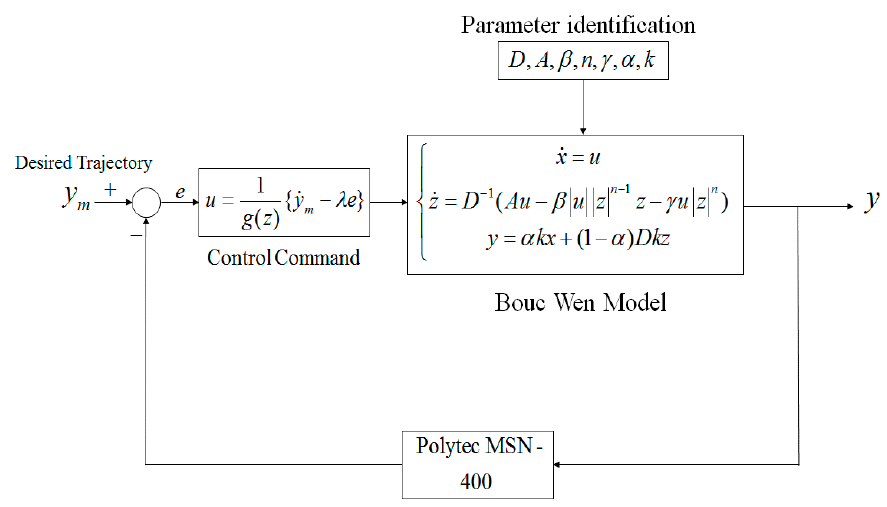
Figure 9. The closed-loop nano-scale positioning design for piezoelectric materials.